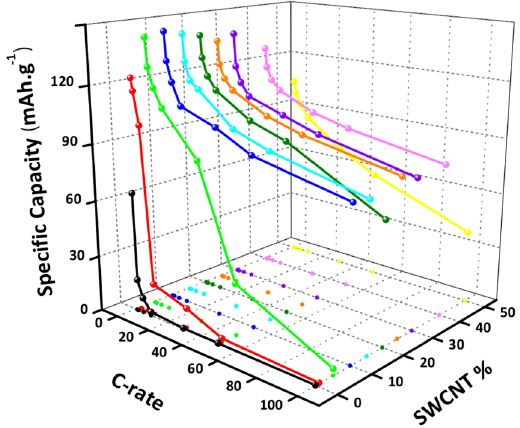
Figure 3. nLTO/SWNCT composites discharge capacities (3 rd cycle) dependence on the carbon nanotubes mass fraction at several different